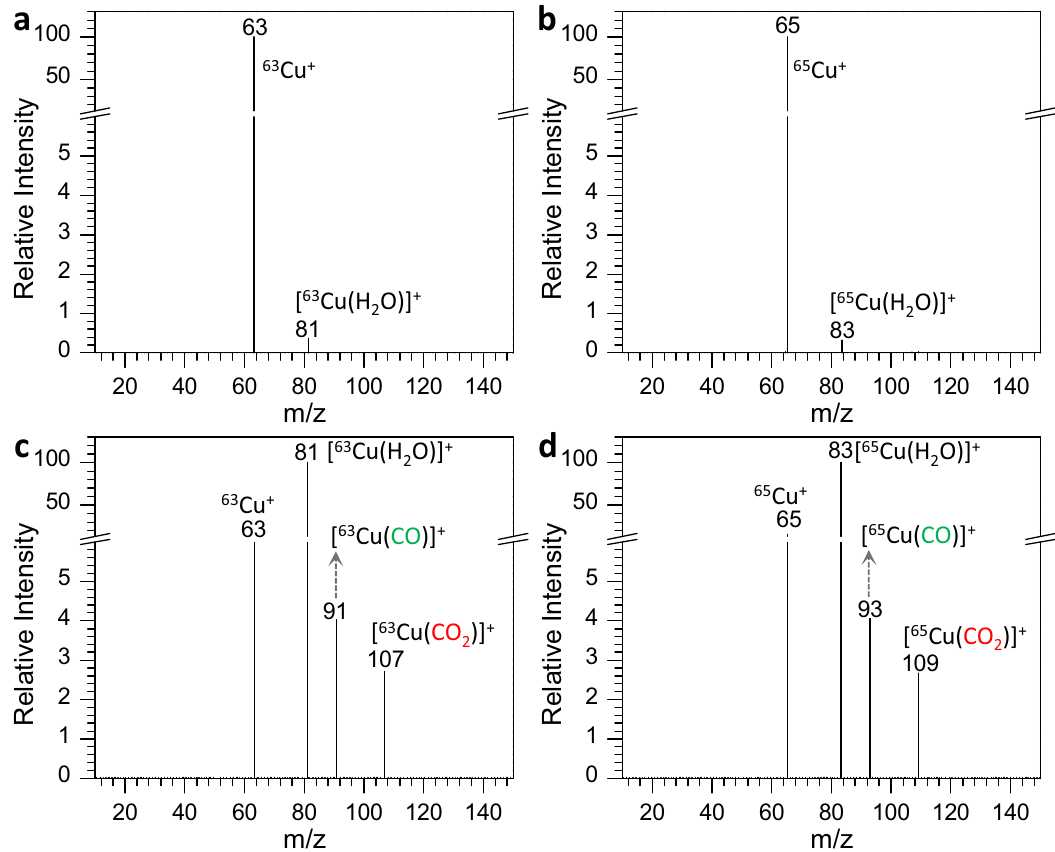
Fig. 2 Mass spectra of CO 2 reduction to CO under different Cu-based catalytic systems. a 63 Cu + b 65 Cu + . c [ 63 Cu(H 2 O)] + . d [ 65 Cu(H 2 O)] + (gas circuit temperature: 280 o C; reaction pressure: 1.5